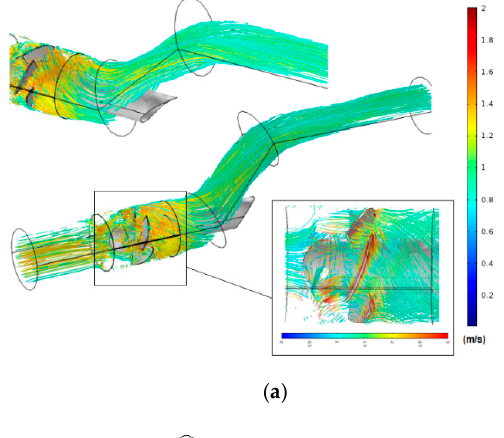
Figure 10. Pressure distribution contours for ( a ) D = 85 mm (design conditions-Model 1) and for ( b ) D = 170 mm (Model 2).